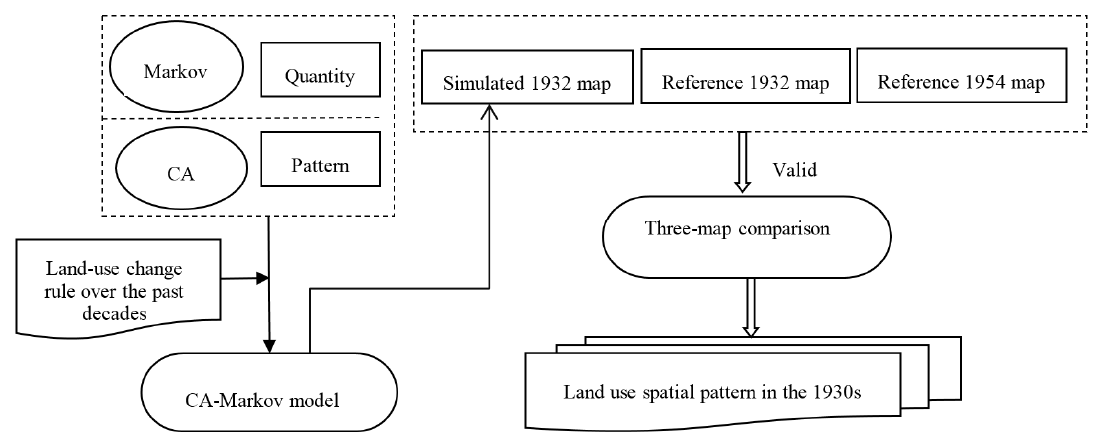
Figure 3. Flowchart of the technical route of land use